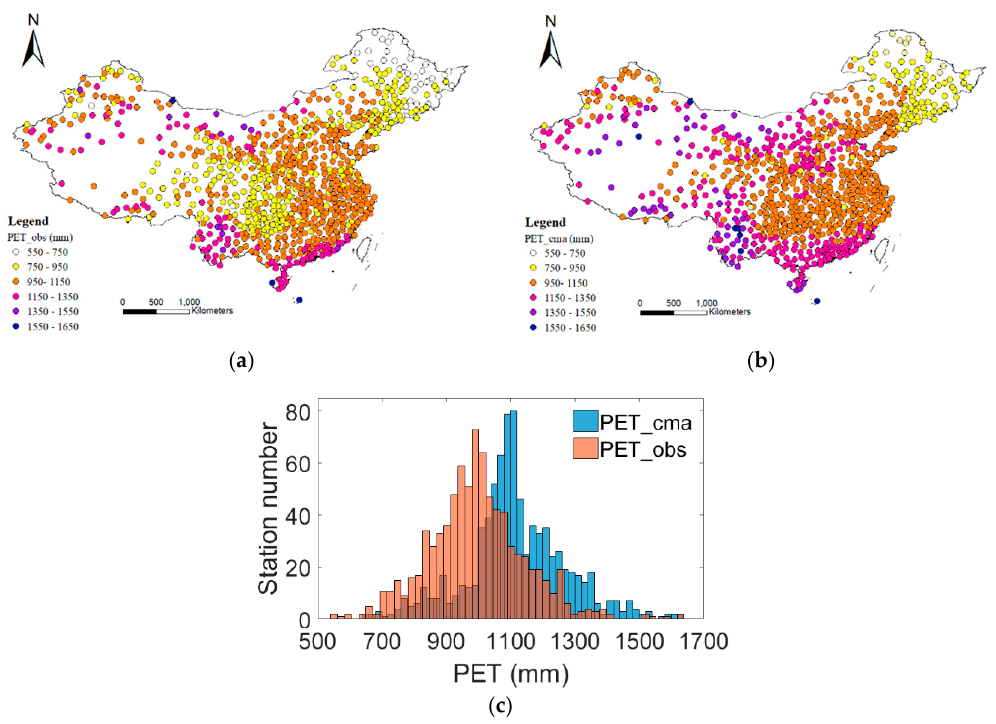
Figure 2. Average annual PET_obs ( a ) and PET_cma ( b ) across China, with their histograms ( c ).